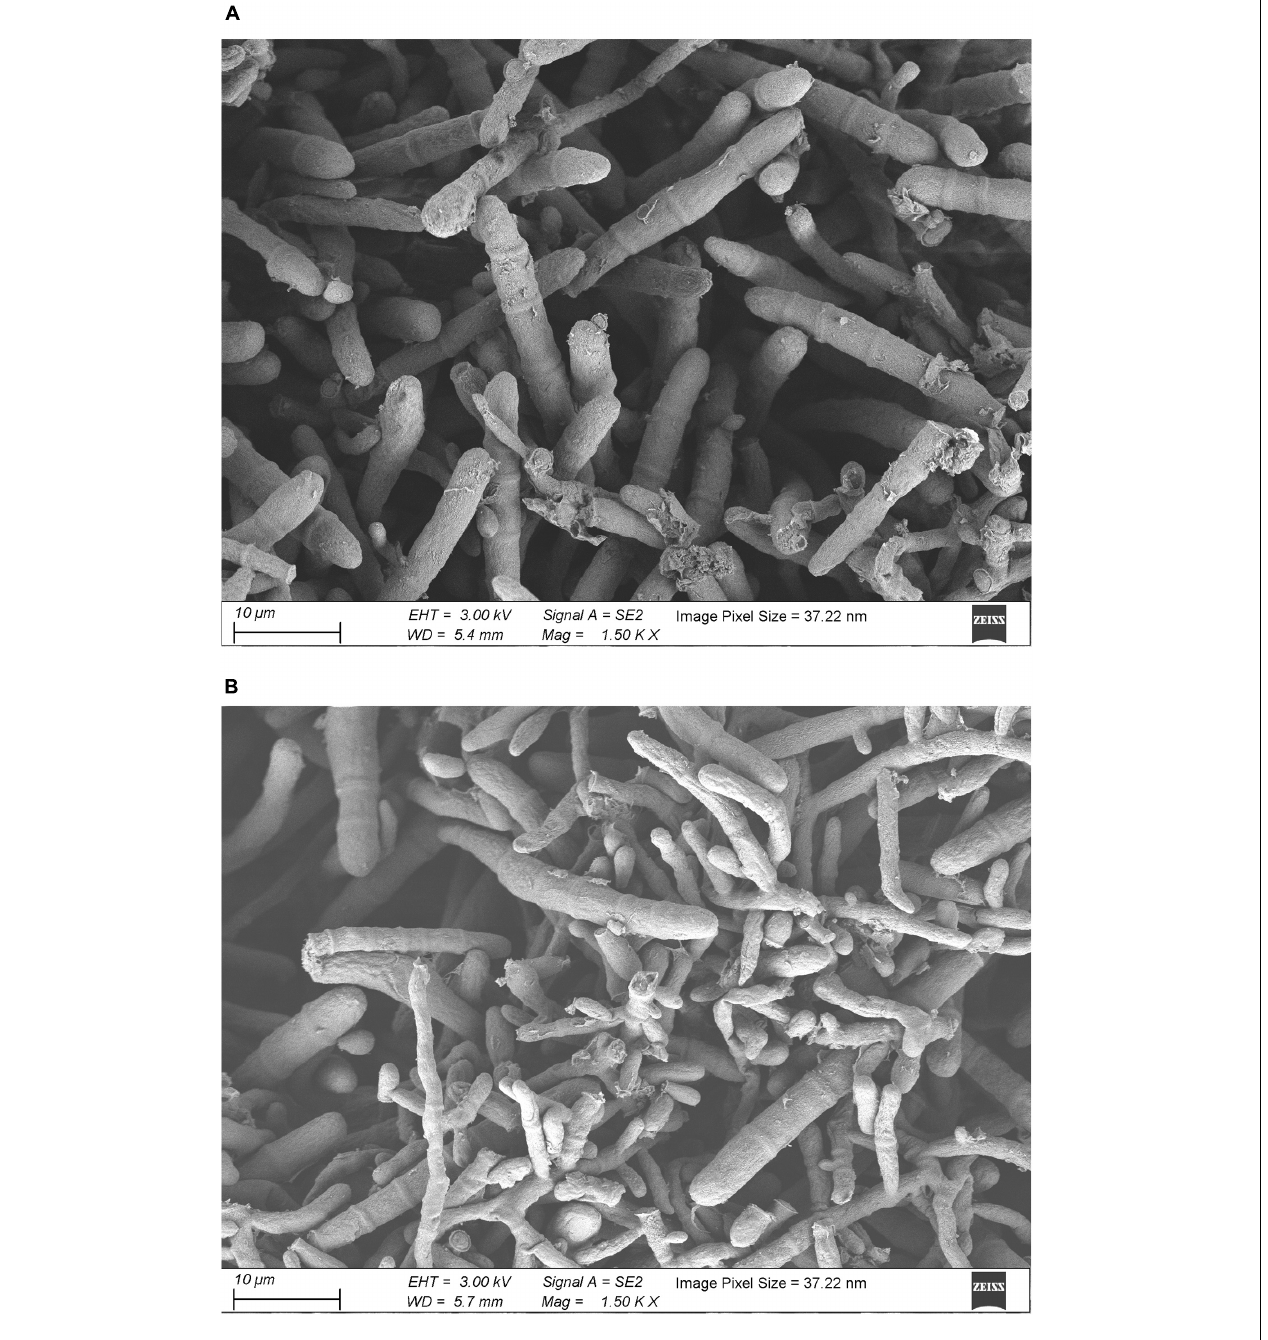
FIGURE 2 | Scanning electron microscopic images of T. rubrum of control group and 256 µ g/mL group (A) control group; (B) 256 µ g/mL